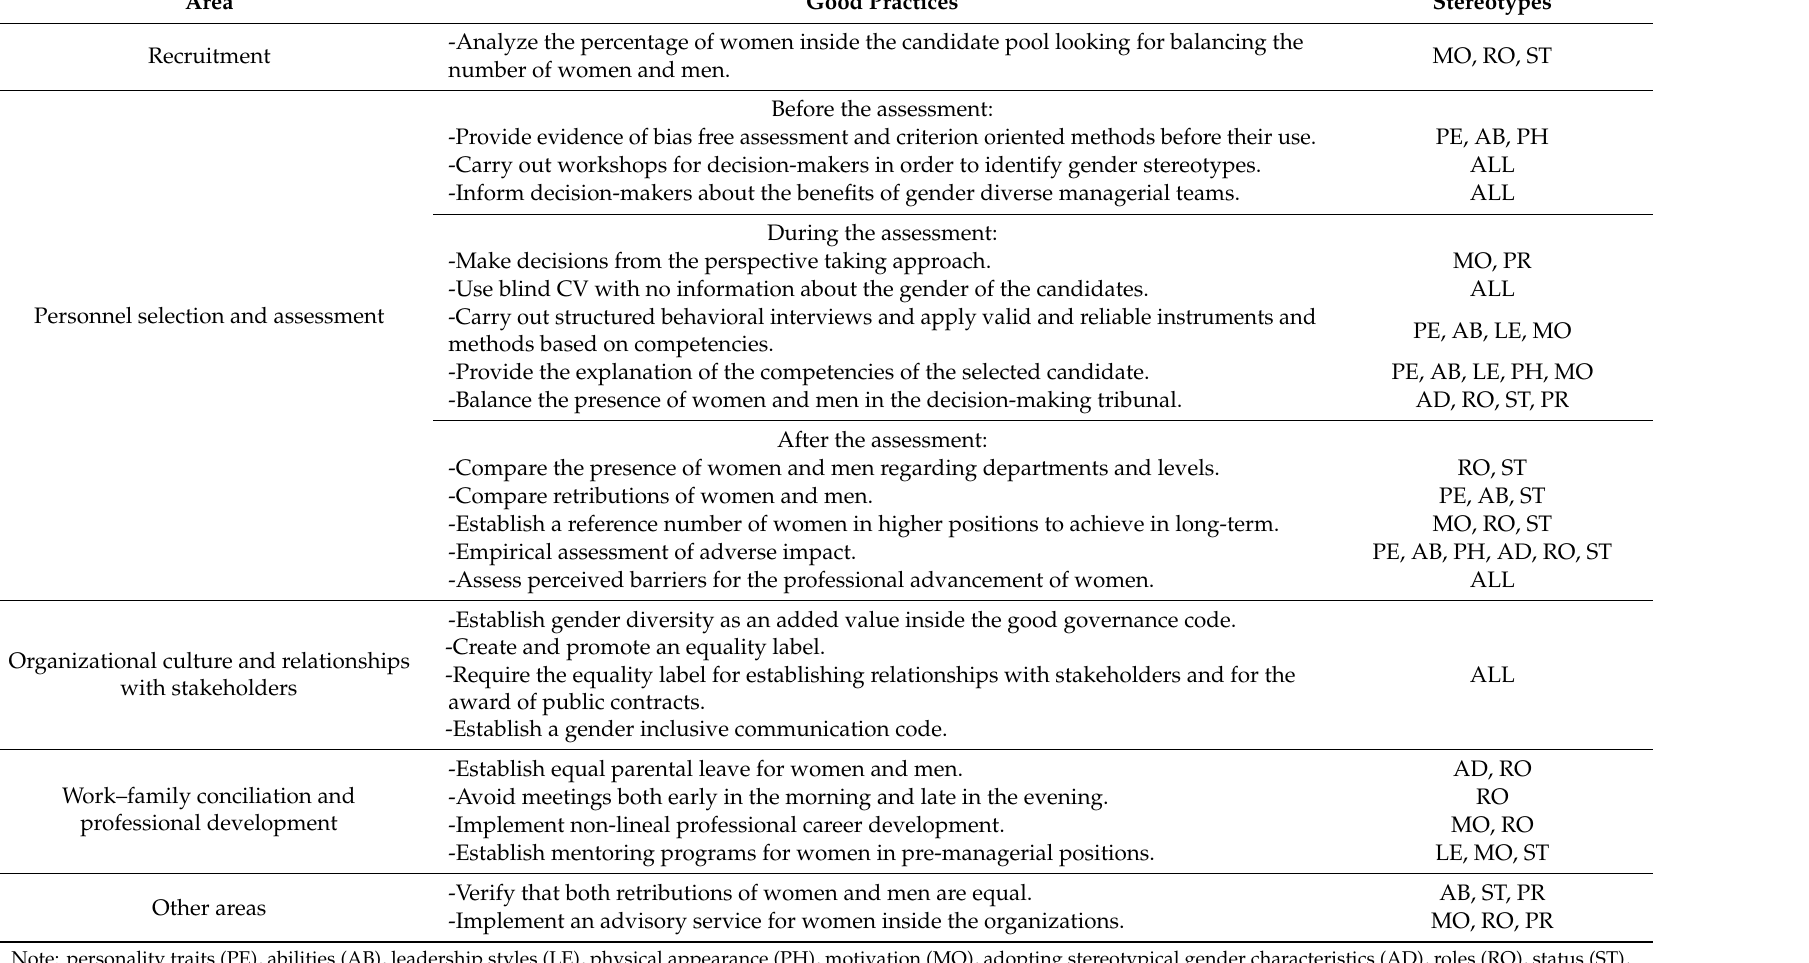
Table 9. Recommendations for good practices at the workplace for bu ff ering gender stereotypes. Area Good Practices Stereotypes -Analyze the percentage of women inside the candidate pool looking for balancing the number of women and men.